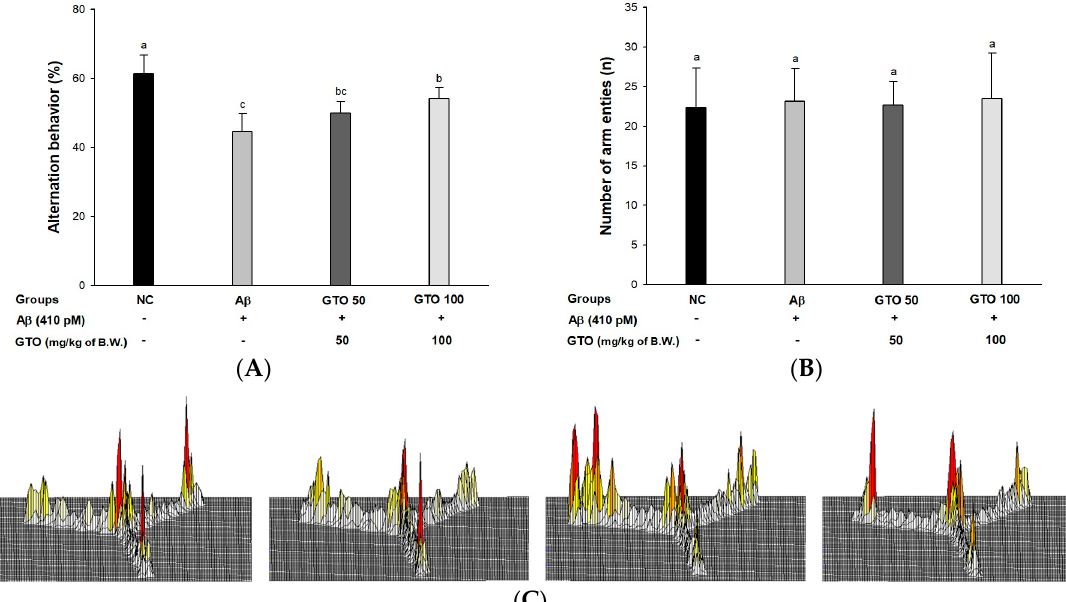
Figure 3. Protective effect of green tea seed oil (GOT) on Y-maze test in A β -induced mice. ( A ) Spontaneous alternation behavior; ( B ) number of arm entries; ( C ) 3D moving routes. Results shown are mean ± SD ( n = 8). Data were statistically represented at p < 0.05, and different lowercase letters indicate statistical significance. NC: A β − / sample − group; A β : A β + / sample − group; GTO 50: A β + / GTO (50 mg / kg of body weight) + group; GTO 100: A β + / GTO (100 mg / kg of body weight) + group. B.W.: body weight.